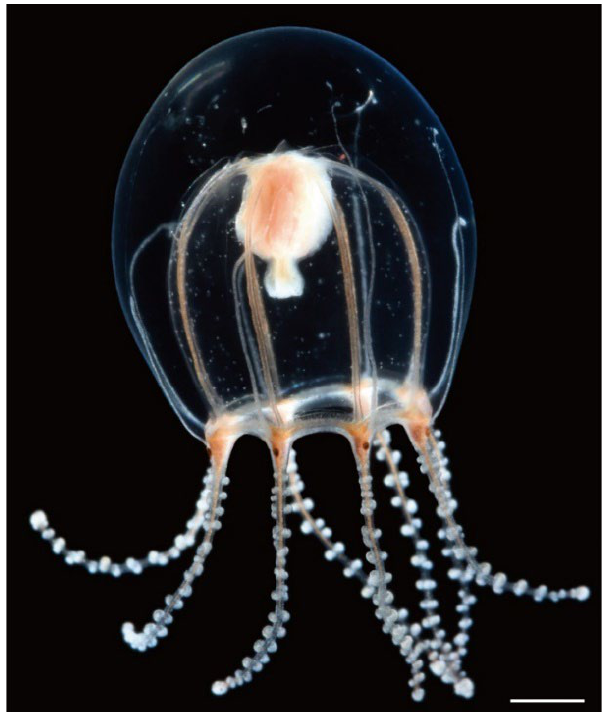
Figure 4. Live mature medusae of Octorhopalona saltatrix sp. nov. (unregisted specimen). Scale bar: 1 mm.